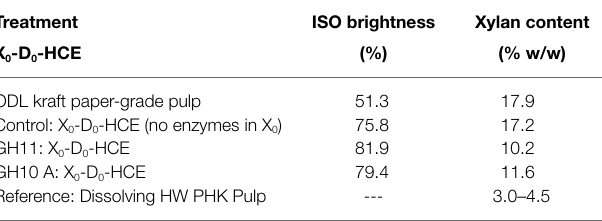
TABLE 1 | Effect of X 0 -D 0 -HCE treatment to oxygen-delignified (ODL) paper-grade kraft pulp on pulp ISO brightness and xylan content. *